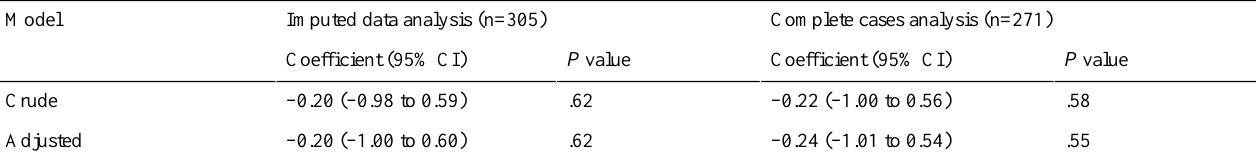
Table 3. Intervention effect on gestational weight gain (primary outcome) assessed using regression analysis a,b,c